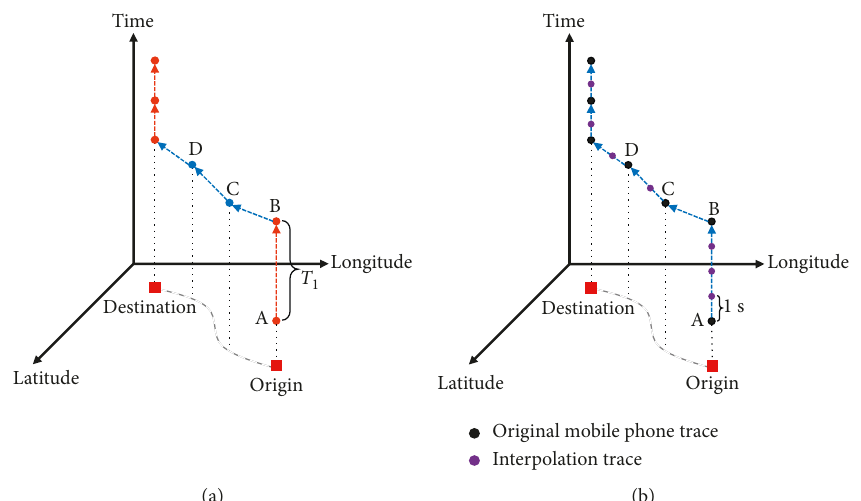
Figure 3: Schematic diagram of time weights of mobile phone traces. (a) Original mobile phone traces. (b) Traces after interpolation.